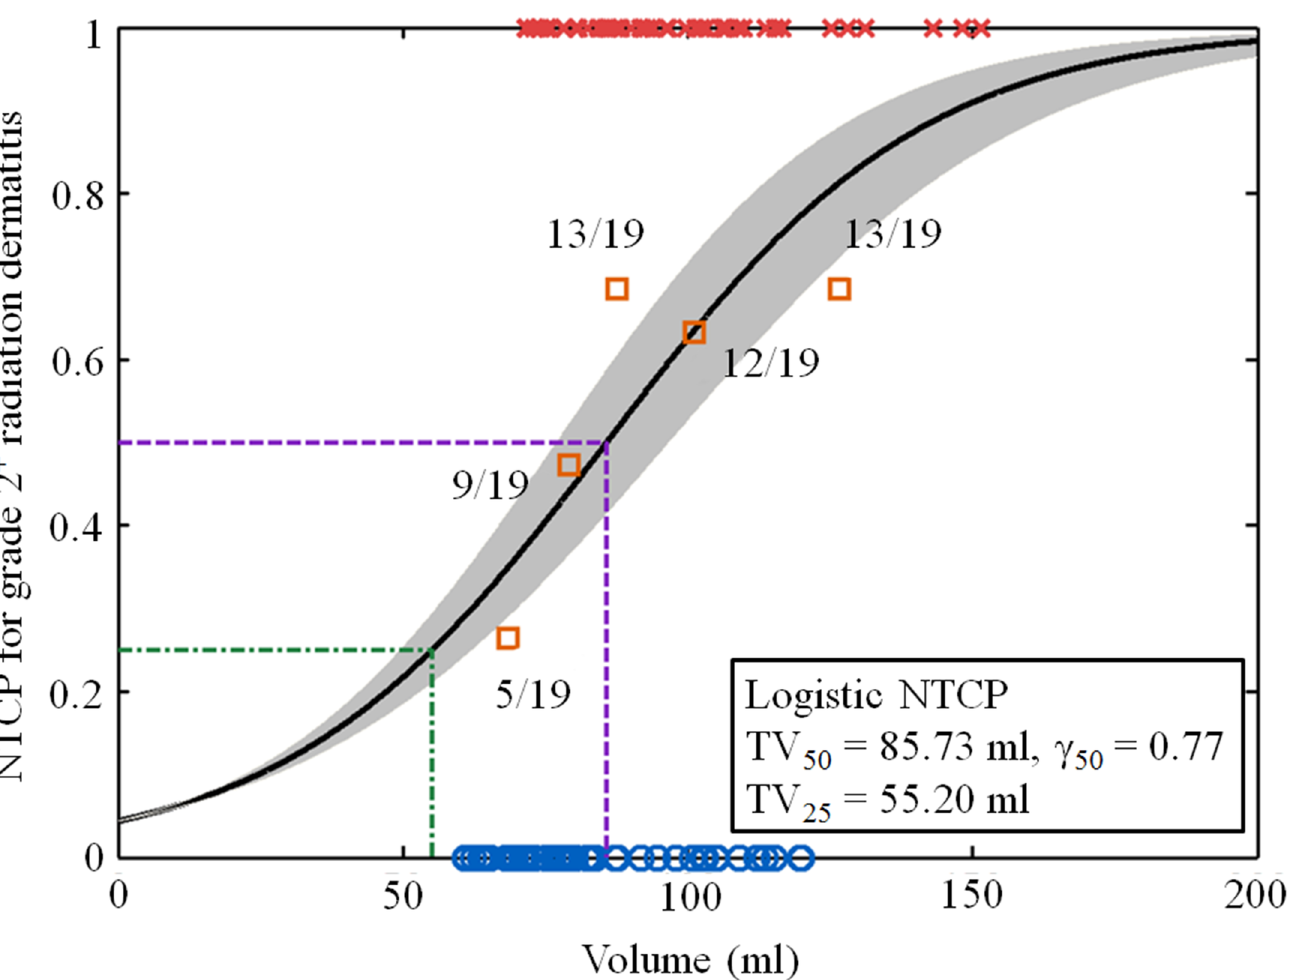
Fig 2. Probability model for normal tissue complications for skin dose of 35 Gy (V 35 ). TV 25 and TV 50 are the tolerance volumes corresponding to complication rates of 25% and 50%, respectively, and γ 50 is the normalized slope of the volume response